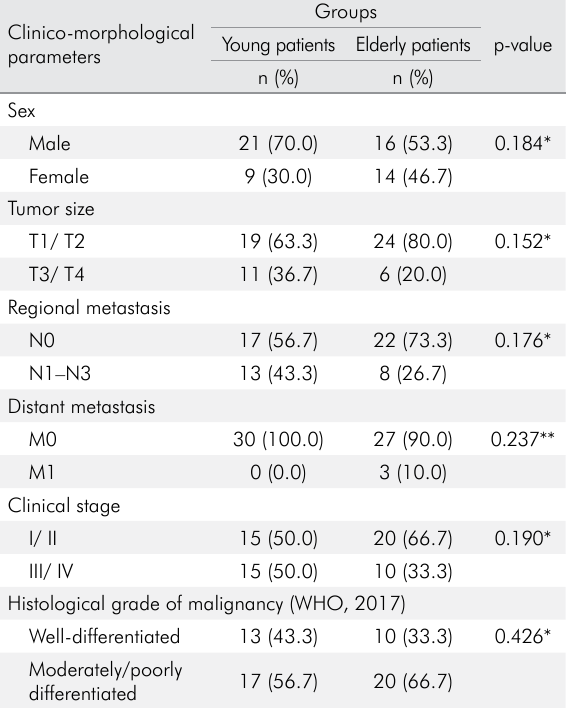
Table 1. Absolute and relative distribution of cases according to age groups and clinico-morphological